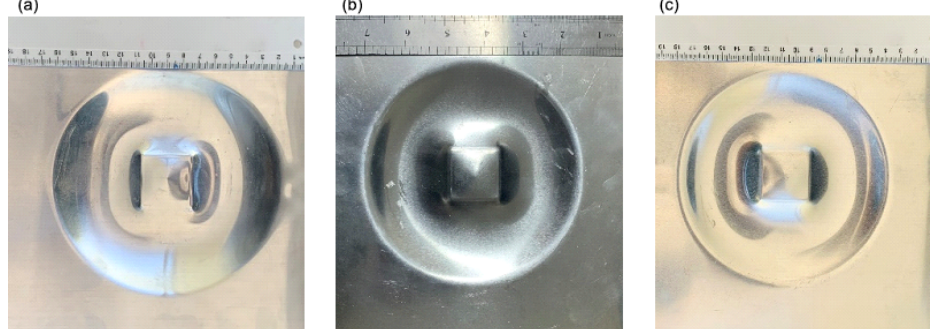
Figure 14. Top view of deformed sheets. (a) Thickness = 1.02mm, V = 2400, N = 6. (b) Thickness = 1.22mm, V = 2800, N = 6. (c) Thick- ness = 1.63mm, V = 2600, N =